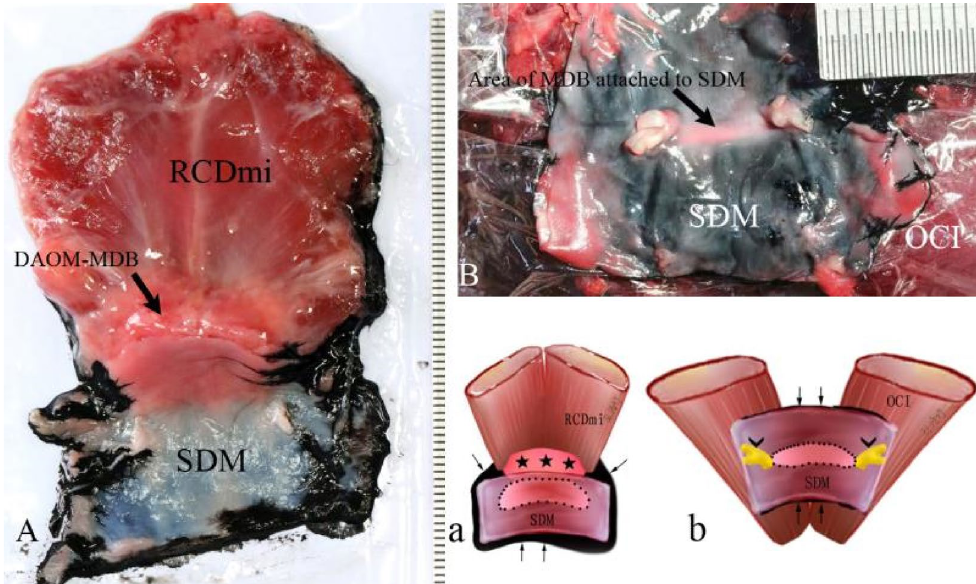
Figure 1. Diagram of the method for showing the connected area between the MDB and the SDM. The contour of the area of the MDB attached to the SDM was showed by infiltrated black ink. Figure 1A: The complex of RCDmi-MDB-SDM located at the dorsal atlanto-occipital interspace; Fig. 1B: The complex of OCI-MDB-SDM located at the dorsal atlanto-axial interspace; Fig. 1a: Illustration for Fig A; Fig. 1b: Illustration for Fig. 1B. Thin black rrows: black ink infiltrated into the narrow gap between the SDM and muscles. Dot line: the connected area between the MDB and the SDM showed up by black ink infiltrating. Stars: DAOM and MDB. Arrowheads: Roots of the spinal nerve.